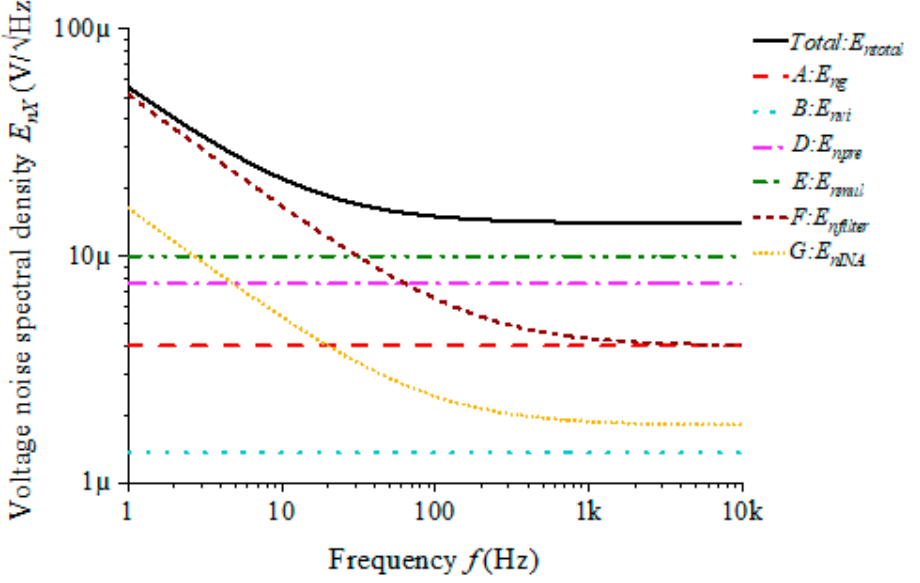
Figure 3. Output voltage noise spectral density of each module: E ntotal is the total output noise, E nX represents the sum of the noise generated inside module X and X represents each module.